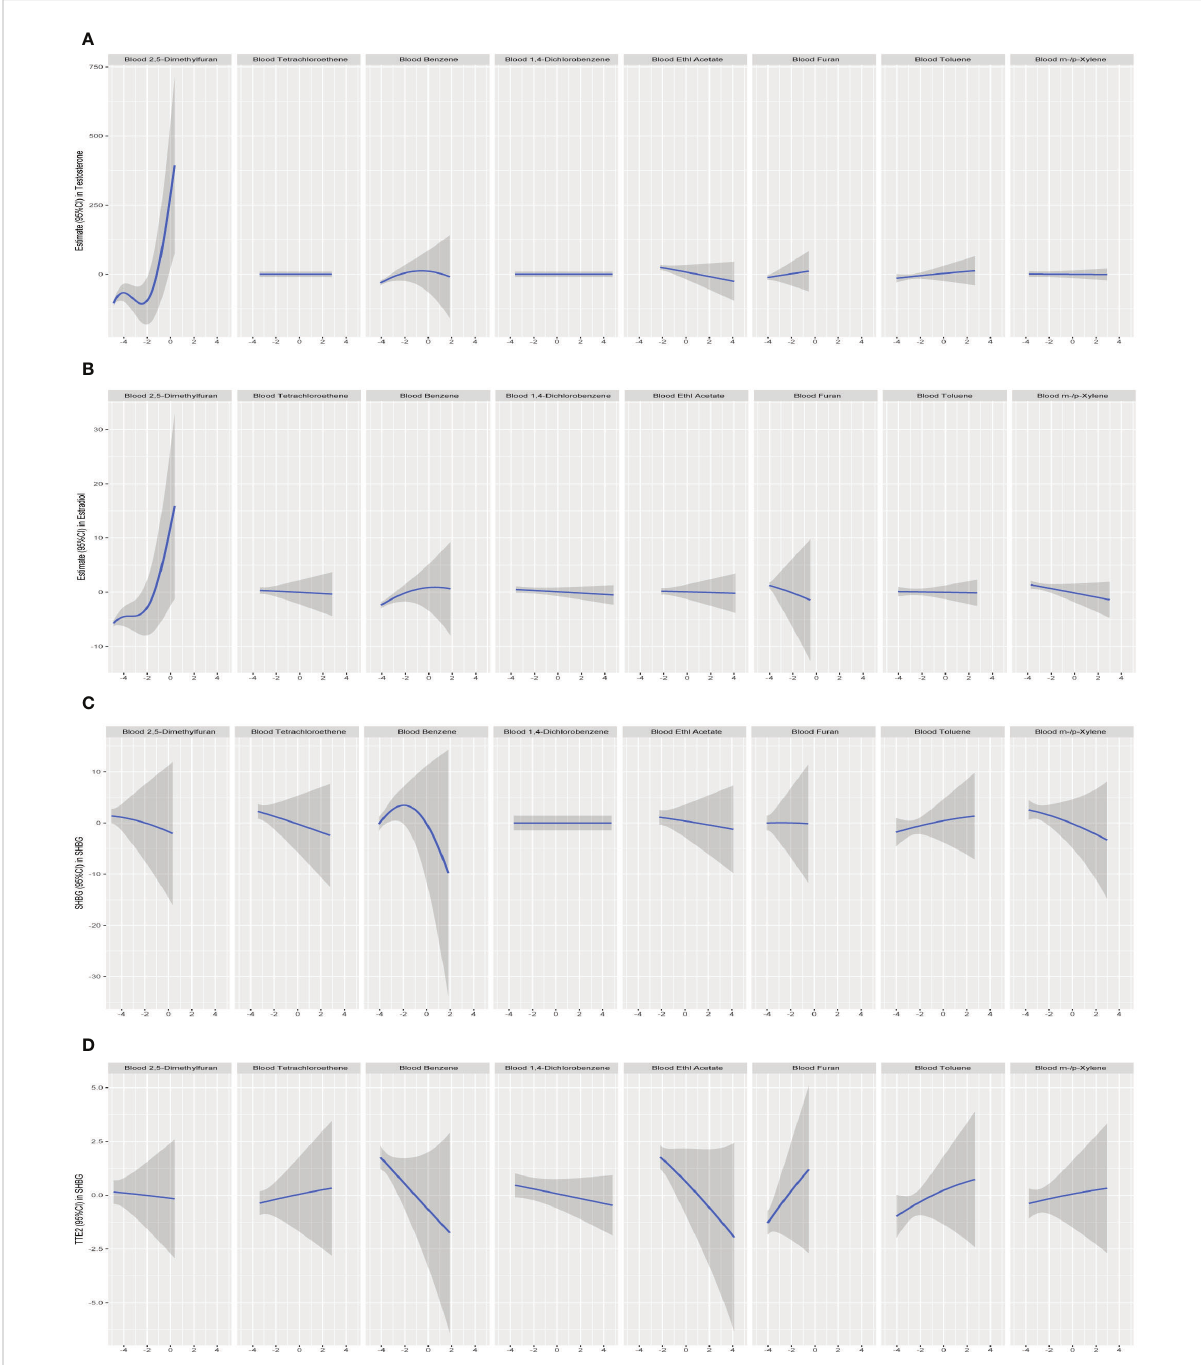
FIGURE 7 Univariate exposure-response relationship between each log-transformed VOCs concentration and estimates of sex hormone all other VOCs were held at their 50th percentiles. (A) Models of blood VOCs and male testosterone. (B) Models of blood VOCs and male estradiol. (C) Models of blood VOCs and male SHBG. (D) Models of blood VOCs and male TT/E 2 . Models adjusted for age, race, education, marital status, body mass index (kg/m2), family income to poverty ratio, smoking and